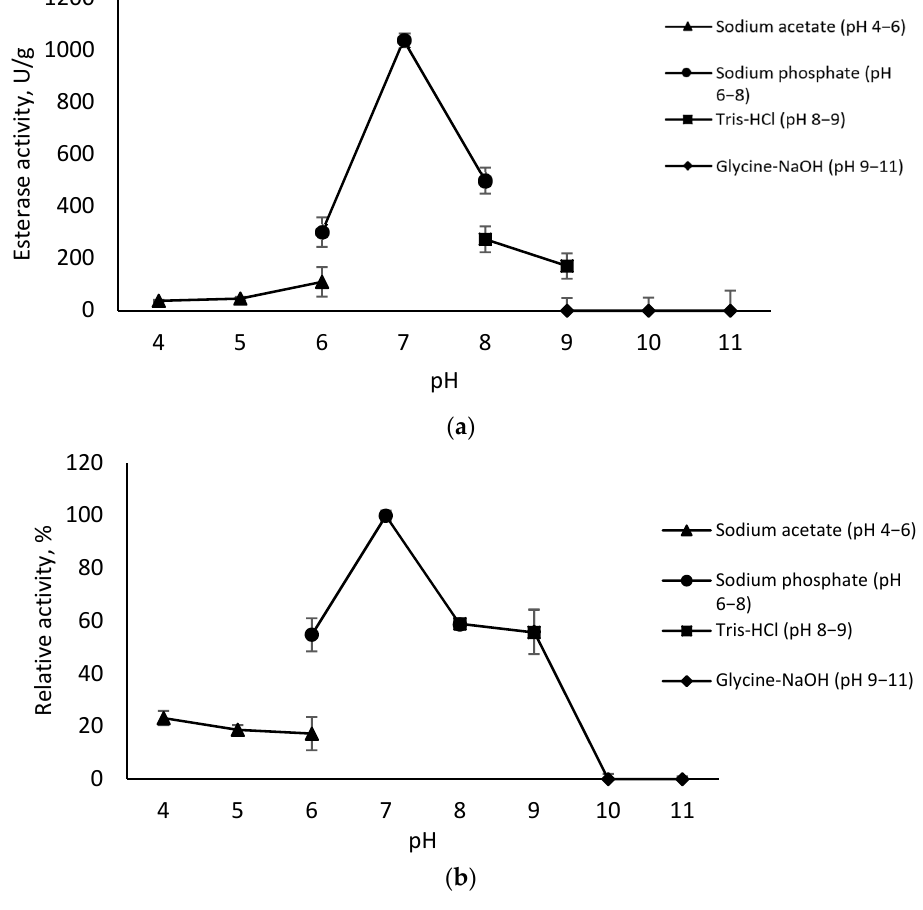
Figure 7. Effect of pH on the immobilized EstD9: ( a ) optimum; ( b ) stability. Enzymatic activity was measured at 80 ° C in standard assay conditions. The relative activity at pH 8 was considered 100%. Error bars represent the standard deviation of means ( n = 3).